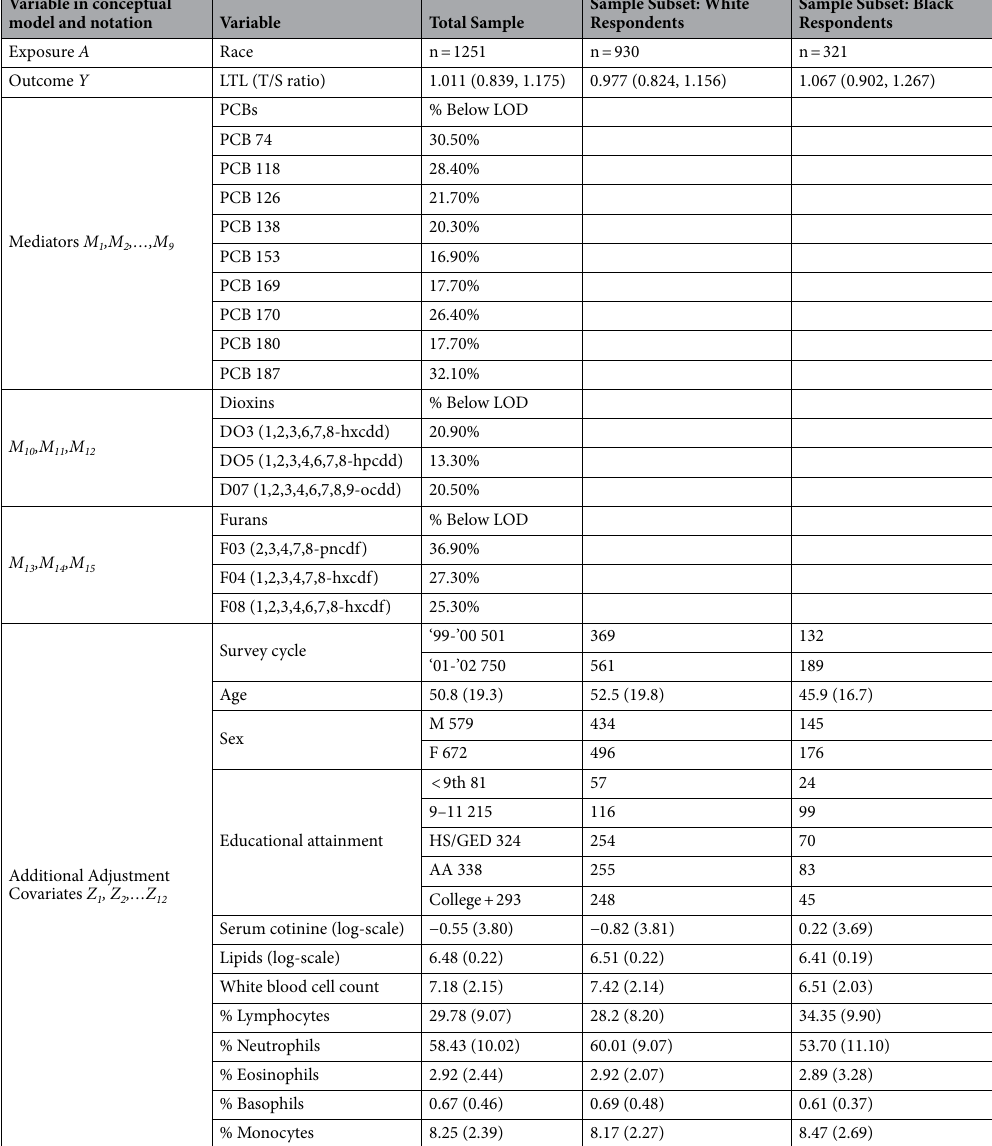
Table 1. NHANES sample characteristics, variables, and notation to be used in the analyses. Counts (%) and mean (SD) or median and interquartile range (IQR) are presented for the exposure and outcome